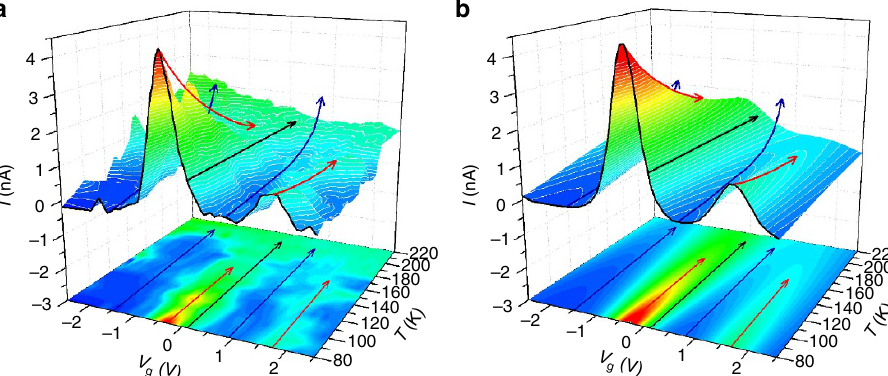
Figure 3 | Variable temperature charge transport. ( a ) 3D plot of the evolution of the tunnel current through a S-(CH 2 ) 4 -Fc-(CH 2 ) 4 -S junction versus gate voltage as the temperature is increased from 80 to 220K for V sd ¼ 10mV. The evolution of the two charge degeneracy points ( (cid:2) 0.3 and 1.7V), whose magnitude decreases with increasing temperature, can be appreciated following the red arrows in both the 3D data and its 2D horizontal projection in the V g - T plane. Similarly, the increase with temperature in the Coulomb blockade areas can be seen by following the blue arrows. The black arrow shows the case for which the molecular level matches the electrostatic potential of one of the leads (resonance), a situation leading to almost negligible temperature dependence. ( b ) Corresponding response of the junction as calculated from the single-level tunnelling transport model in equation (1) using the parameters given in Table